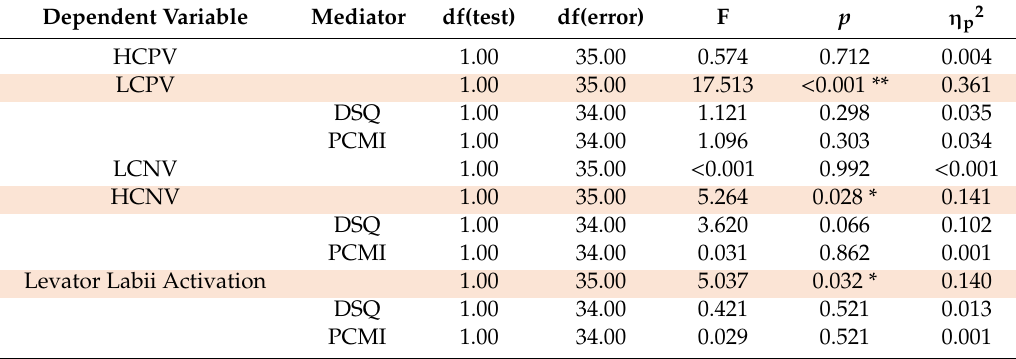
Table 4. Appraisal of Contact with Depression and